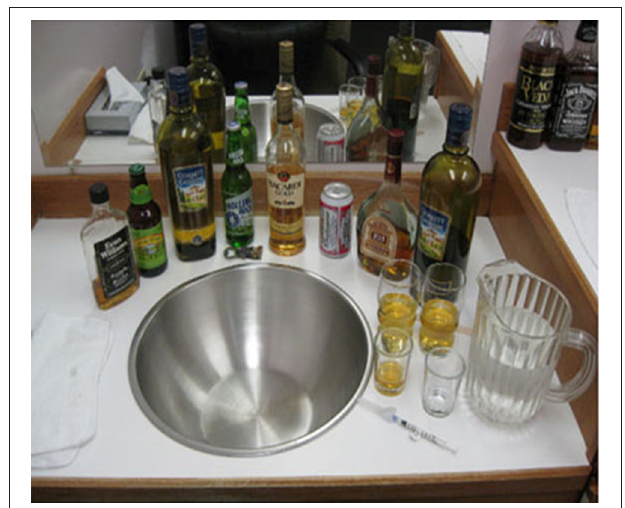
FIGURE 1 | A typical setup of an alcohol treatment room.